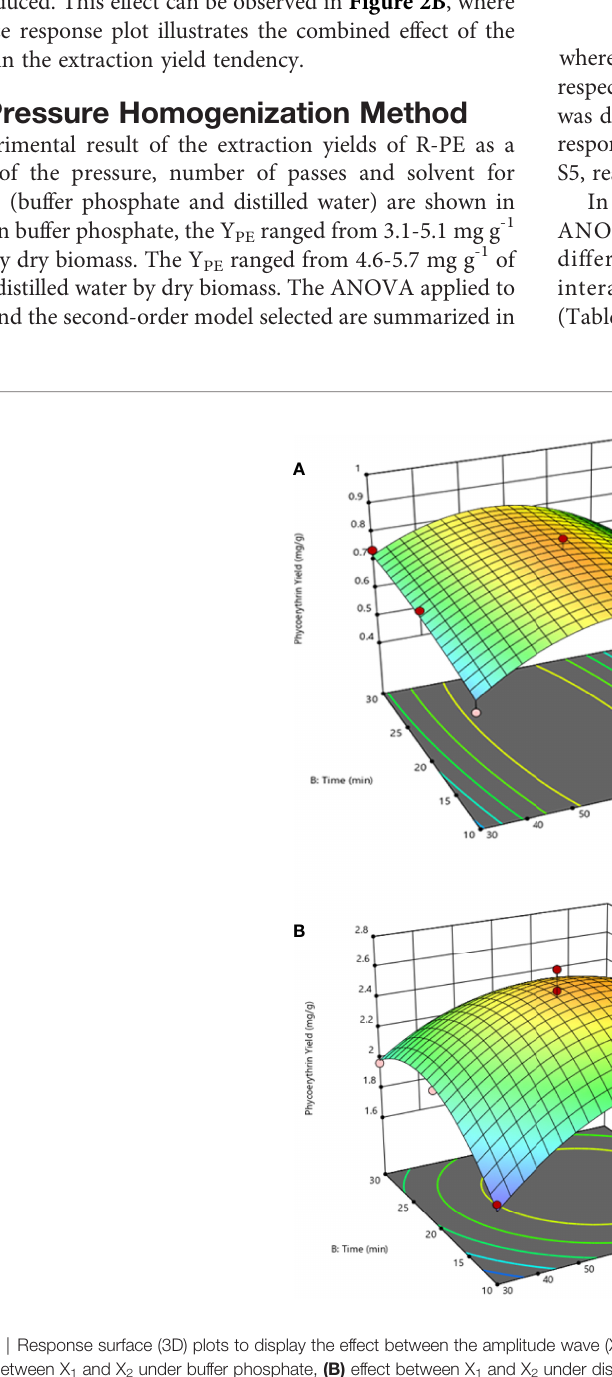
Table 4 (Eq. 12 and 13). The mathematical model represents the extraction yield as a function of the independent variables (pressure and number of passes) for each solvent of extraction